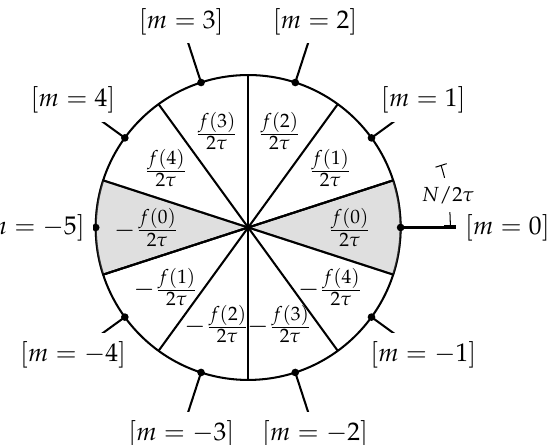
Figure 1. Illustration of the “slices” for the integer-wise LWE encryption and bootstrapping procedure when τ =